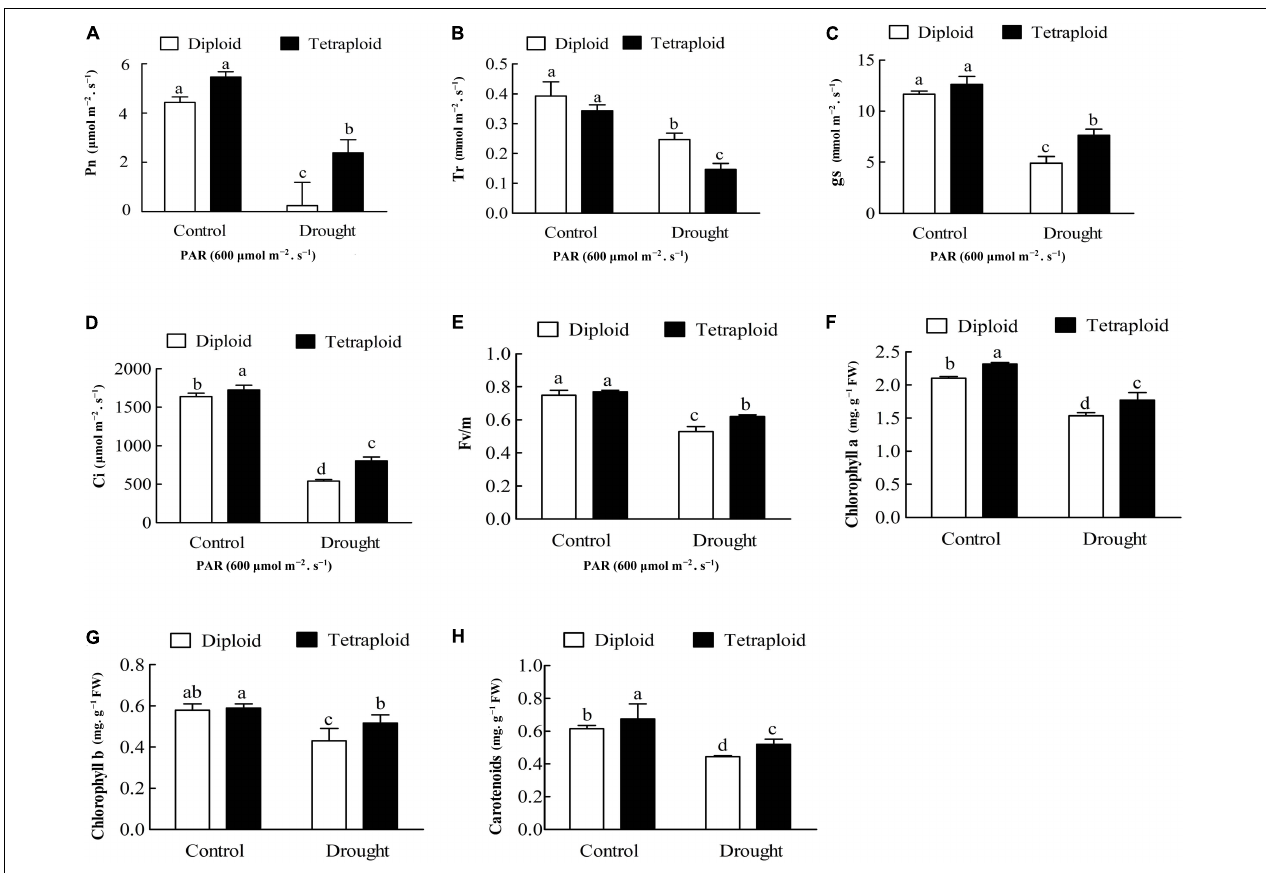
FIGURE 5 | Photosynthetic analysis in diploids and tetraploids Citrus wilsonii under drought stress. (A) Pn; (B) Tr; (C) gs; (D) Ci; (E) Fv/Fm; (F) chlorophyll a content; (G) chlorophyll b content; (H) carotenoid content. Values sharing the same lower case letters (a–d) are not significant by ANOVA at P < 0.05.